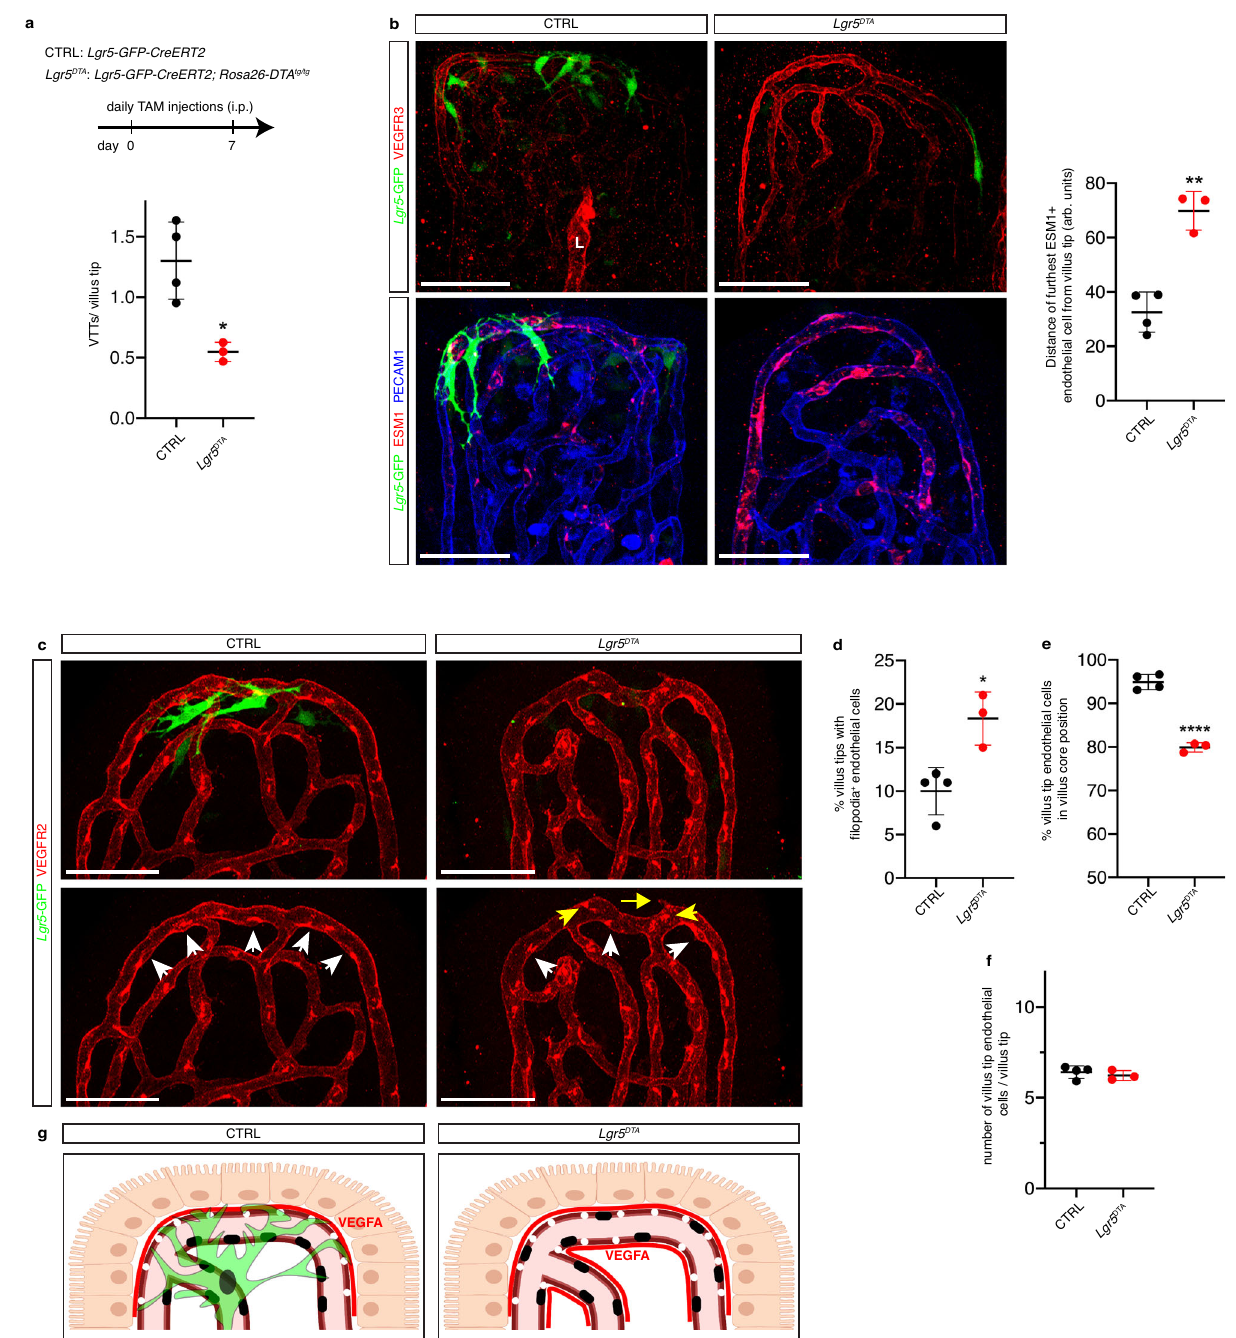
Fig. 3 VTTs constrain villus tip VEGFA signaling. a Reduced number of VTTs in Lgr5 DTA mice. Quanti fi cation of VTTs/villus in control Lgr5-GFP-CreERT2 and Lgr5 DTA mice after 1 week of deletion ( p = 0.0112, n = 3 – 4 mice). b VTT depletion increases villus tip endothelial VEGFA signaling. Staining for PECAM1 (blue) and VEGFR3 (red, top) or ESM1 (red, bottom). L, lymphatic vessel. Quanti fi cation of distance at which ESM1 + vessels are observed from the villus tip in either control or Lgr5 DTA mice after 1 week of deletion ( p = 0.0011, n = 3-4 mice). c – f VTT depletion disturbs villus tip vessel polarization and phenotype. c Endothelial cell nuclei are polarized towards the villus core (white arrowheads, perinuclear VEGFR2 staining) or epithelial side (yellow arrowheads) of villus tip vessels. Endothelial cells displaying fi lopodia (yellow arrows). Staining for VEGFR2 (red) and GFP (green). d – f Quanti fi cation of the ( d ) percentage of villus tip endothelial cells displaying fi lopodia ( p = 0.0123), ( e ) percentage of endothelial cells on the villus core side of the vessel ( p < 0.0001) and ( f ) the number of endothelial cells/villus tip in control and Lgr5 DTA mice; n = 3 – 4 mice. g Scheme of VEGFA signaling phenotype in the presence (left) or absence (right) of VTTs. The presence of VTTs con fi nes VEGFA signaling to villus tip vessels and promotes villus tip endothelial cell nucleus polarization. VTT depletion increases VEGFA signaling and disturbs villus tip endothelial cell polarization (created with biorender.com). All microscopic images were generated from whole-mount immunostaining. Scale bars: 50 μ m. * P < 0.05, ** P < 0.01, **** P < 0.0001 2-tailed unpaired Student ’ s t test. All values shown as mean ± SD. Source data are provided as a Source Data fi